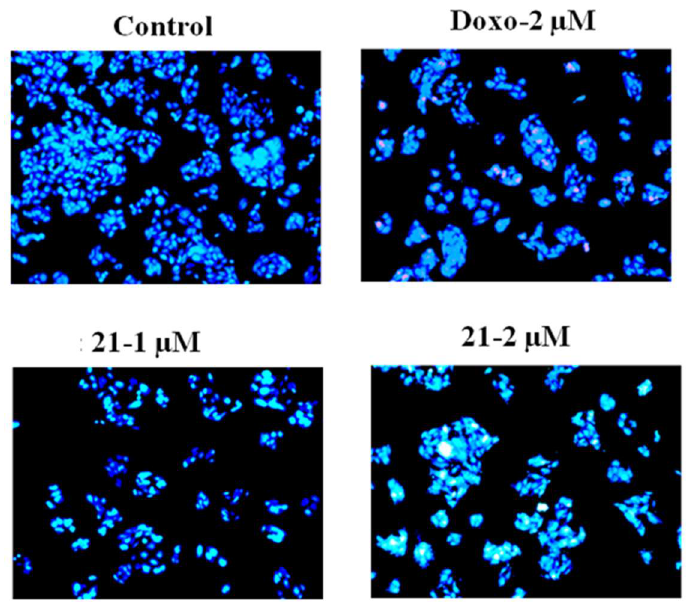
Figure 7. Hoechst staining in the A549 cell line; represents control cells and cells treated with Doxorubicin (2 µ M) and barbatic acid ( 21 ) at 1 and 2 µ M concentrations. Florescence images were captured by Olympus microscope using 10X lens.